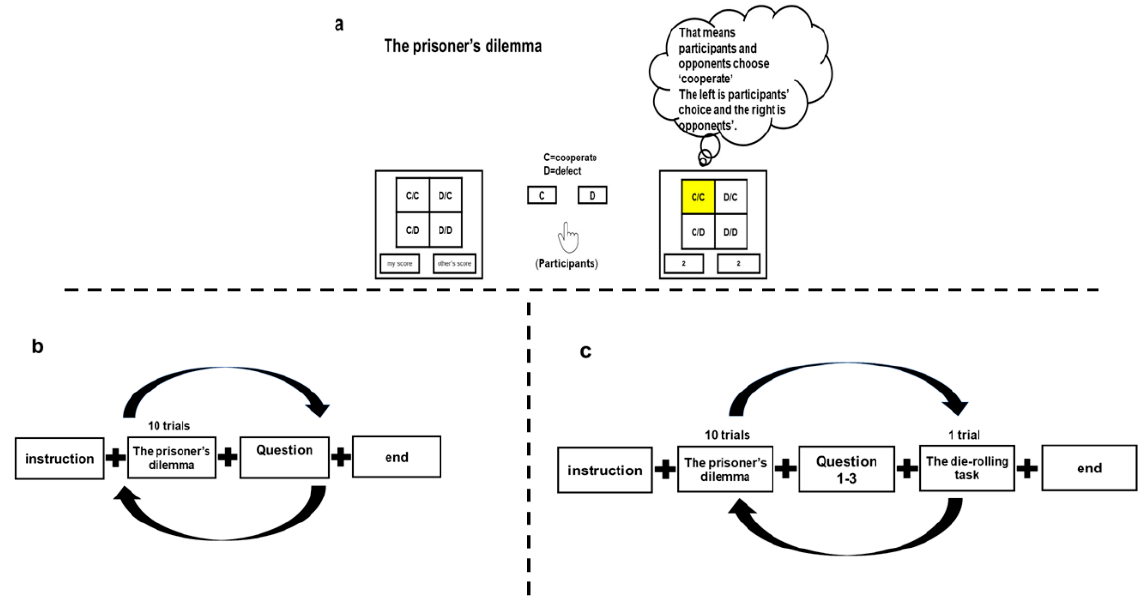
Figure 1. ( a ) The prisoner’s dilemma paradigms: Examples of an interaction sequence with the playing partner (right icon). After instruction, the participant had to decide between the defective (D) and the cooperative (C) choice, which was followed by the presentation of buttons (my score and other’s score) depicting the choice and outcome for both players. The left side (in color) is the participant’s choice and the right side is the opponent’s choice. The payoff started by zero at the start and then was accumulated. ( b ) Experiment flow chart. At the beginning, participants chose to “cooperate” or “defect” with opponents (confederates that participants met who were replaced by computer algorithms). After each block of 10 rounds, participants were asked to respond on 1–7 scales to a question about perceived fairness rating: “In the previous block, do you think the opponent’s choices were fair to you (1 = very unfair, 7 = very fair)?” the experiment had 60 rounds/trials. ( c ) Experiment flow chart. At the beginning, participants chose to “cooperate” or “defect” with opponents (who were actually confederates who were replaced by computer algorithms). After each block of 10 rounds, (1) participants were asked to respond on1–7 scales to three questions: (1)